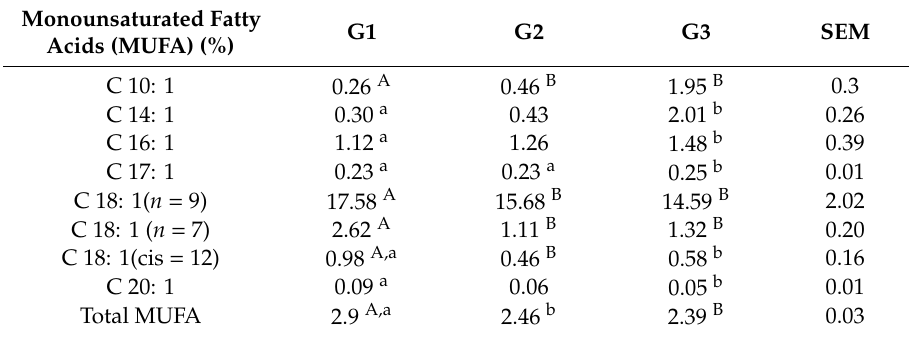
Number of fatty acids in sheep’s milk during the lactation–column header; G1—Group lambing in February (milked from April to August)–column header; G2—Group lambing in June (milked from August to October)–column header; G3—Group-lambing in June (milked from August to November and melatonin-treated before 6 weeks parturition)–column header; a,b —means within a row with di ff erent lowercase superscripts di ff er significantly at